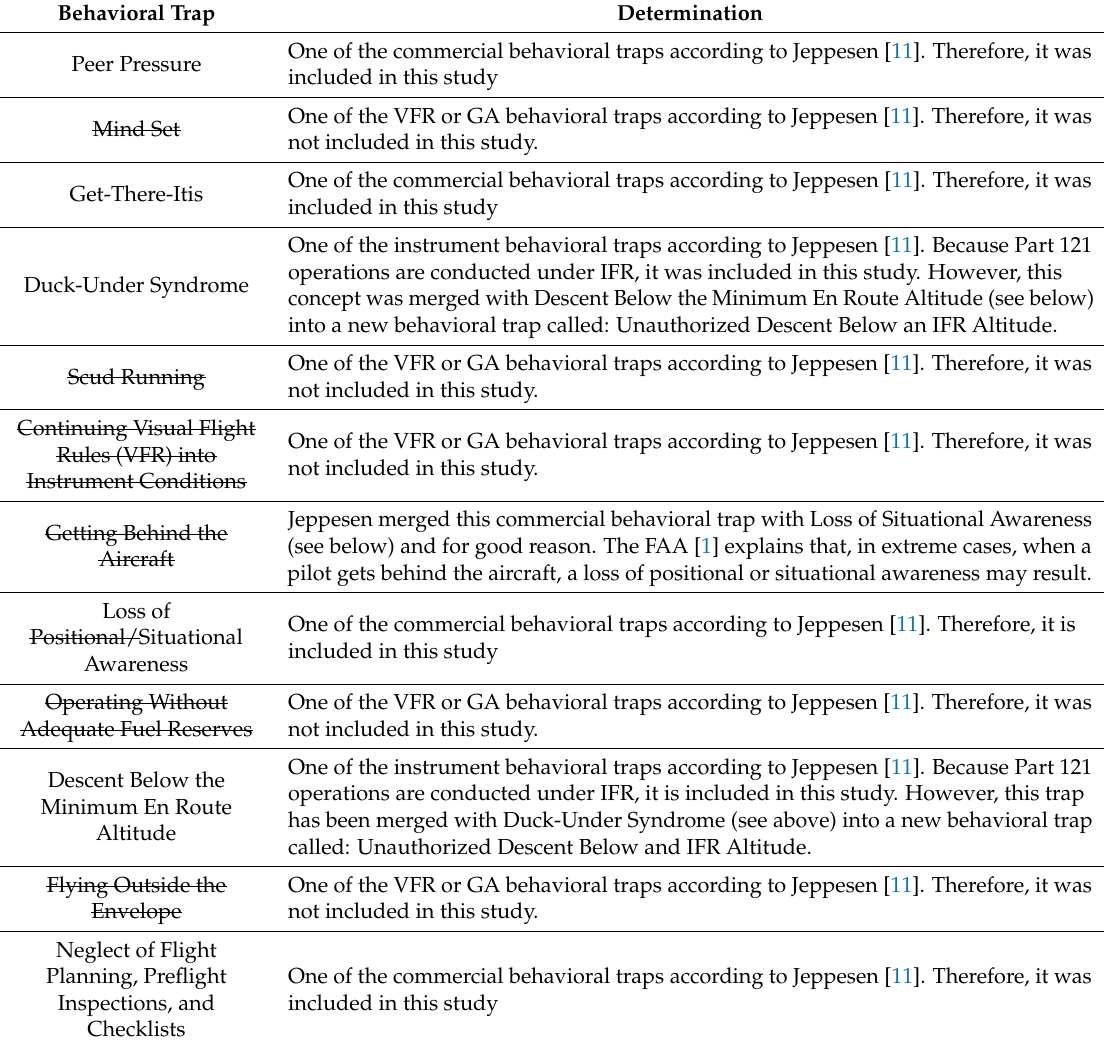
Table 3. Justification for inclusion or exclusion of behavioral traps for this study. GA, General